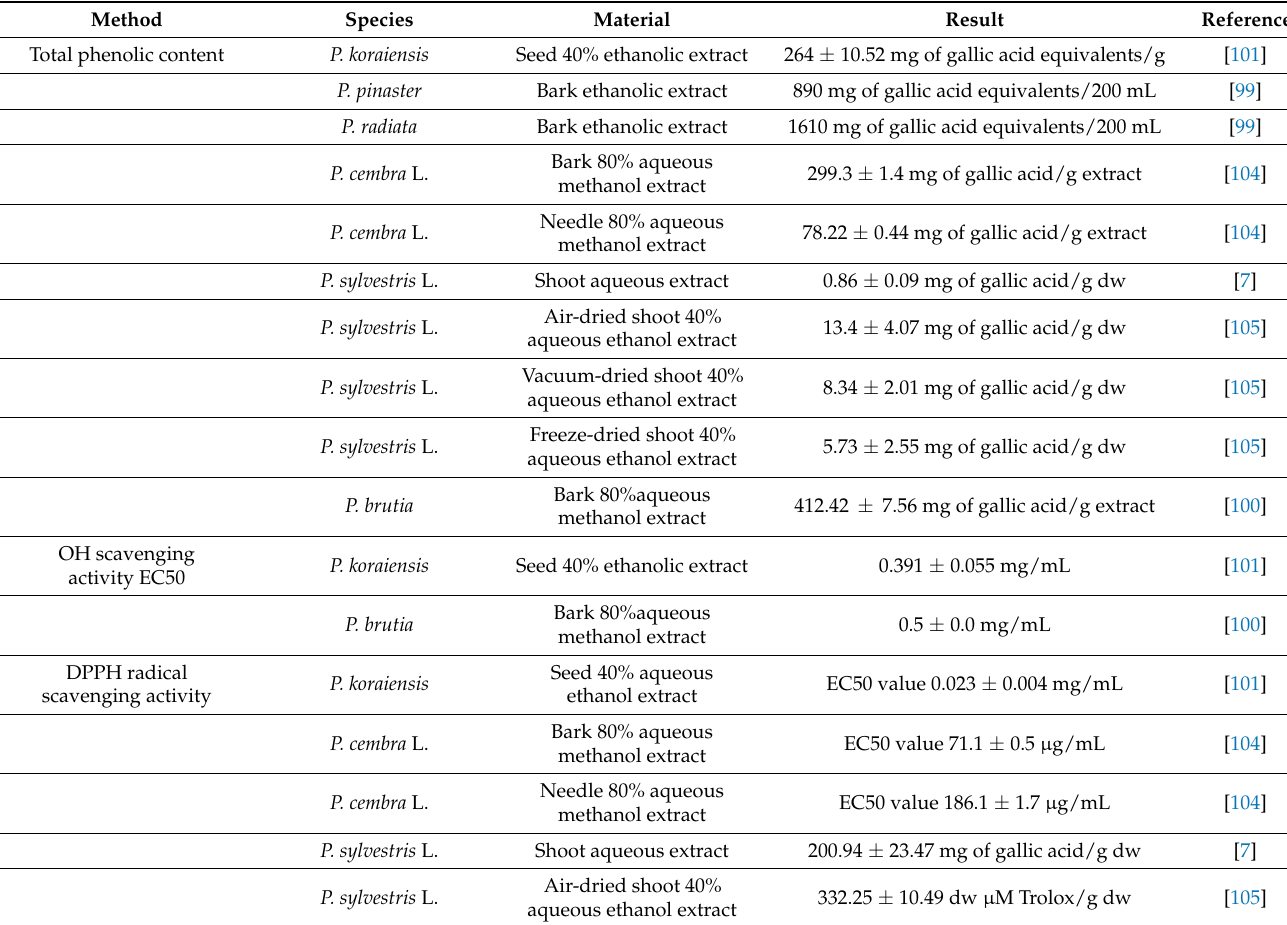
Table 6. Antioxidant properties of various Pinus